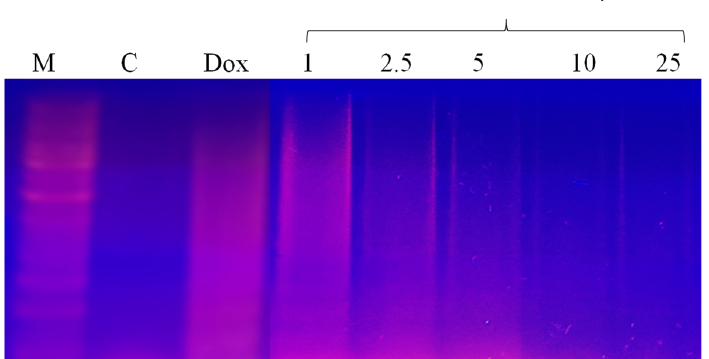
Figure 8. DNA ladder in KB3-1 cells following 24 h exposure to the compound 3.6 and doxorubicin (Dox, 1 µ М ).